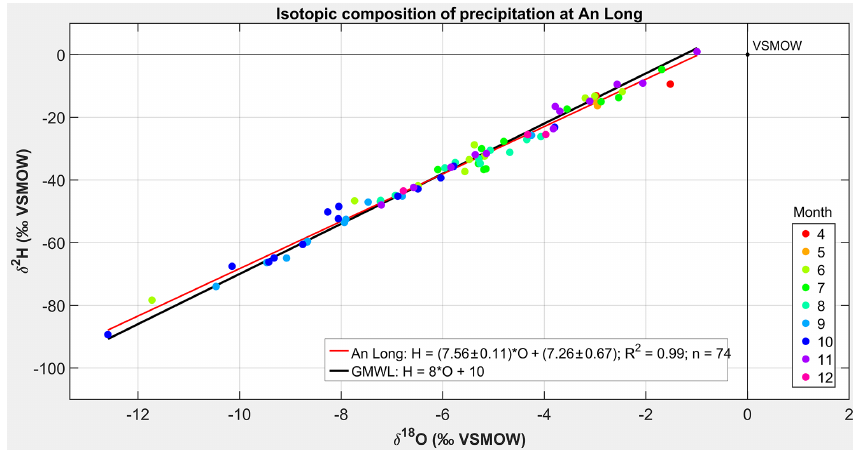
Figure 7. The LMWL of An Long in comparison to the GMWL.